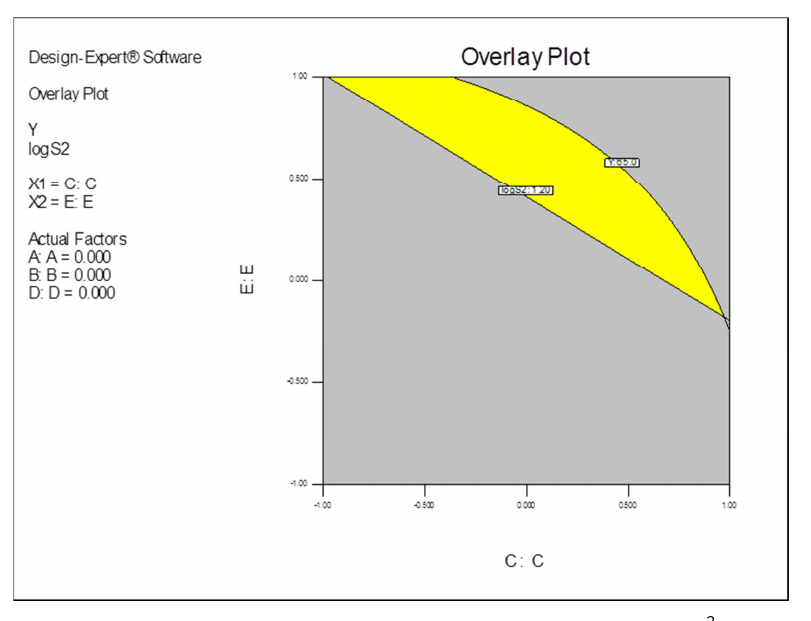
Figure 3 – Area of regulation for optimal Y and minimal logS 2 , B =